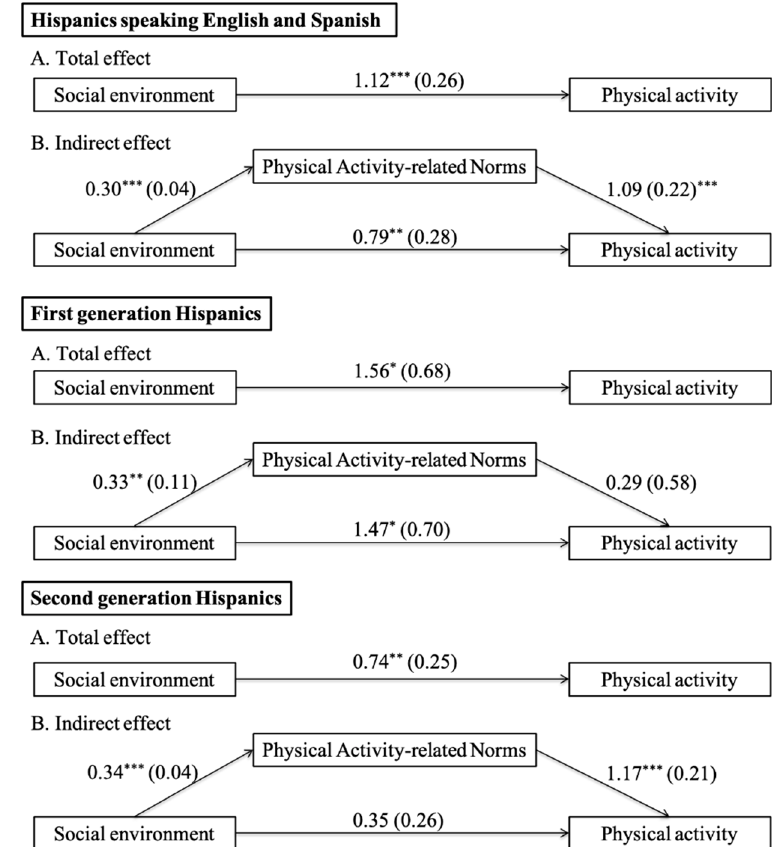
Figure 3. Path diagram for the effect of the social environment on physical activity after bootstrapping. * p < 0.05, ** p < 0.01, *** p < 0.001. Note: Numbers indicate unstandardized regression coefficients and standard errors in parentheses. A represents the total effect of the social environment on frequency of physical activity, and B represents the indirect effect of the social environment on frequency of physical activity through physical activity-related norms. The social environment was measured based on a four-item scale on neighborhood safety, traffic, and crime. Neighborhood physical activity-related social norms were measured based on child-reported indicators whether seeing people being active on the streets. Higher scores indicate higher quality social environment or more physical activity-promoting norms. All analyses were conducted with adjustment for covariates listed in Tables 3 and 4.